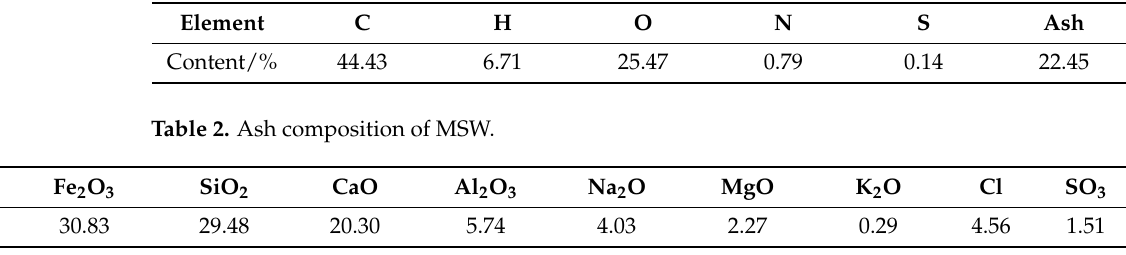
Table 1. Elemental analysis of MSW (dry basis).